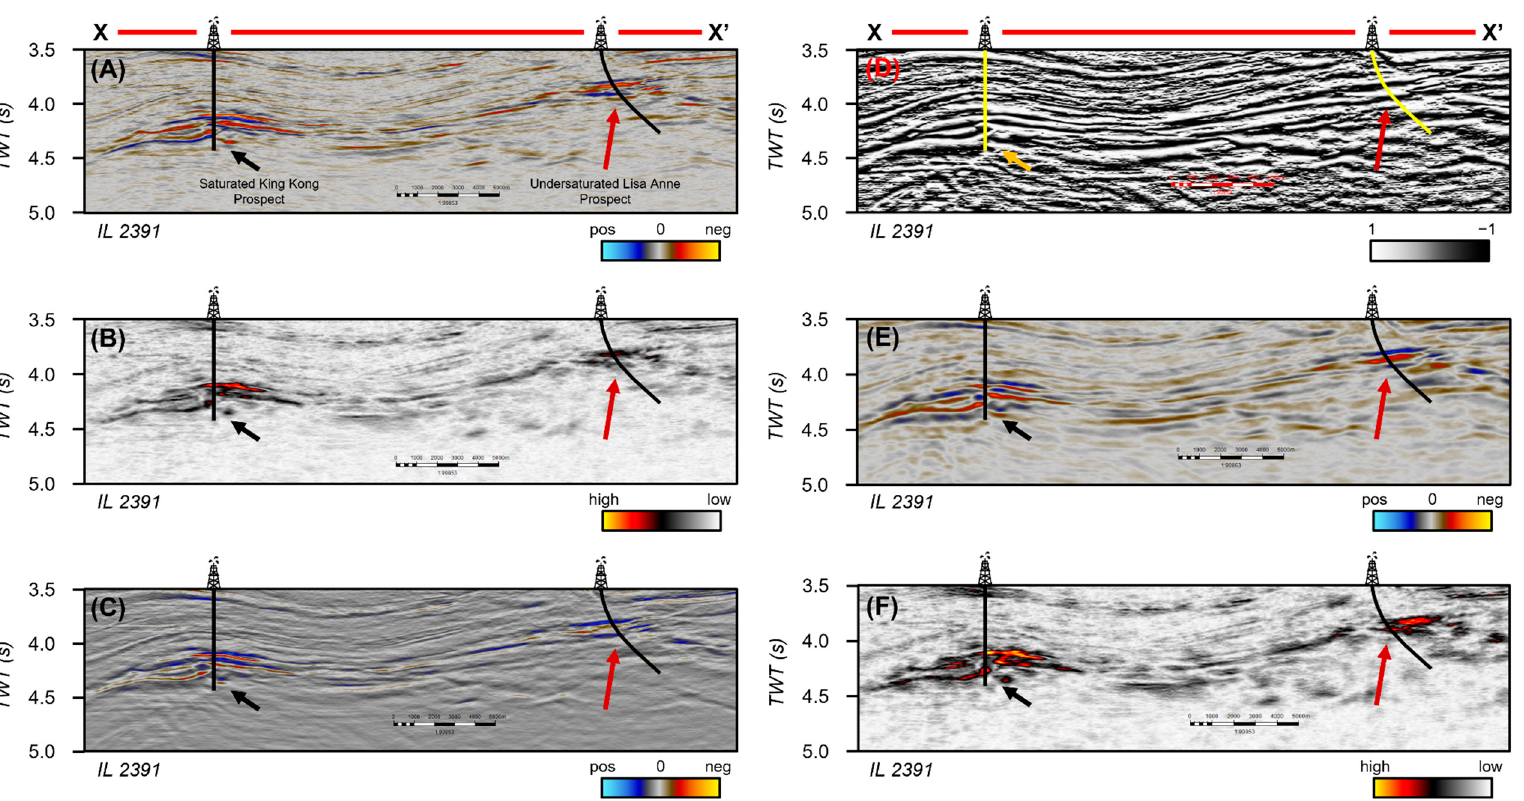
Figure 8. All the attributes from PCA that were used as an input into the KK/LA SOM where ( A ) is the full-stack amplitude, ( B ) is the envelope, ( C ) is the Hilbert, ( D ) is the cosine of instantaneous phase, ( E ) is the relative acoustic impedance, and ( F ) is the sweetness. The saturated King Kong Reservoir is shown by the black and orange arrows whereas the undersaturated Lisa Anne prospect is shown by the red arrow.